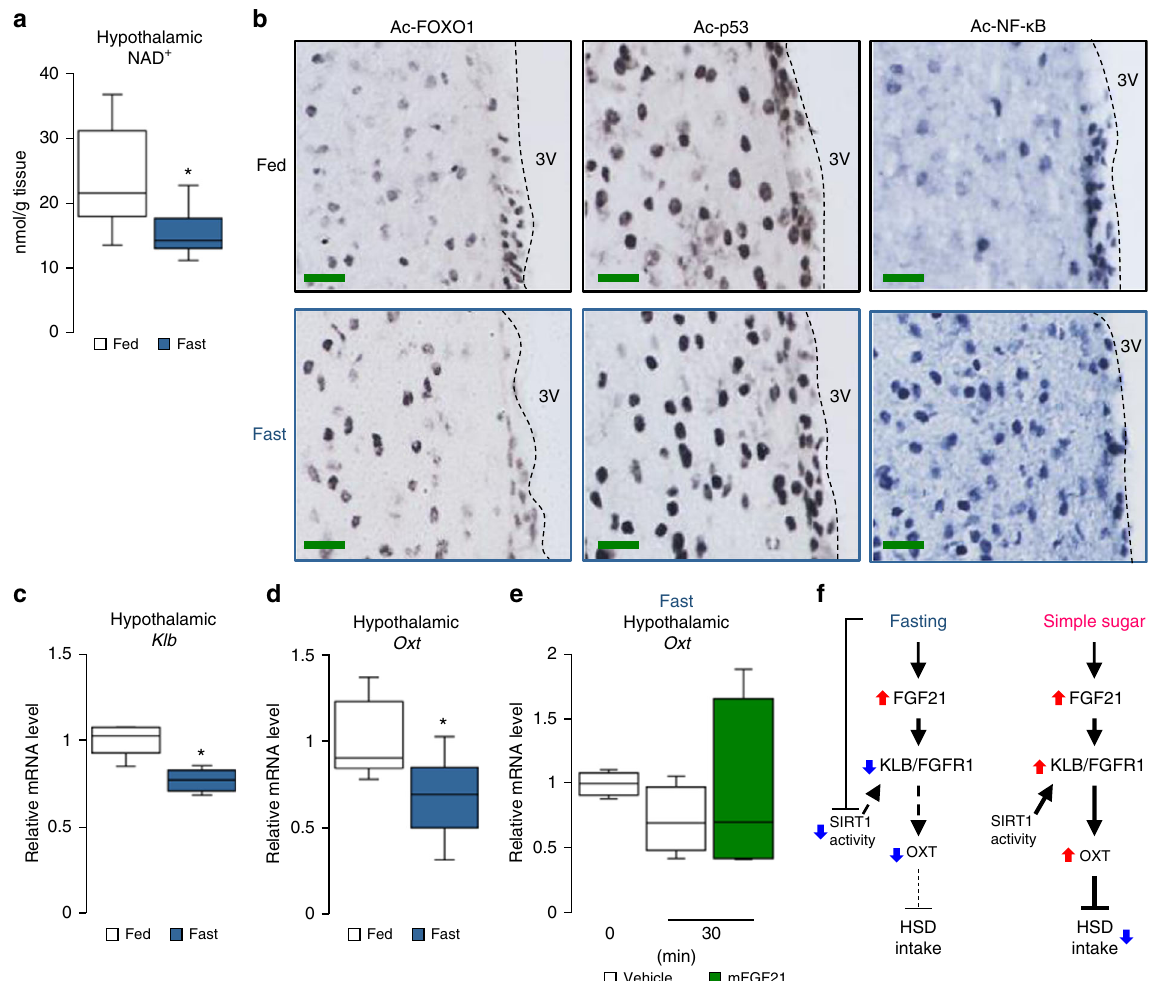
Fig. 9 Fasting attenuates hypothalamic SIRT1 activity and hypothalamic FGF21-Oxt signalling. a The effects of feeding and fasting on hypothalamic NAD + levels ( n = 12 in the Fed group, n = 13 in the Fasted group). b Photomicrographs depict hypothalamus coronal section from wild-type C57BL/6 mice (fed or fasted state) that received 3rd ICV injection of 0.5 μ l of TSA (10 μ g/ μ l). The length of scale bars is 100 μ m. The sections were immunostained to identify Ac-FOXO1, Ac-p53 and Ac-NF- κ B protein (black or blue) expression. c , d The effects of feeding and fasting on hypothalamic expression levels of Klb ( c ) ( n = 6 in the Fed group, n = 7 in the Fasted group) and Oxt ( d ) ( n = 6 in the Fed group, n = 7 in the Fasted group) in C57BL6/J mice fed ad libitum